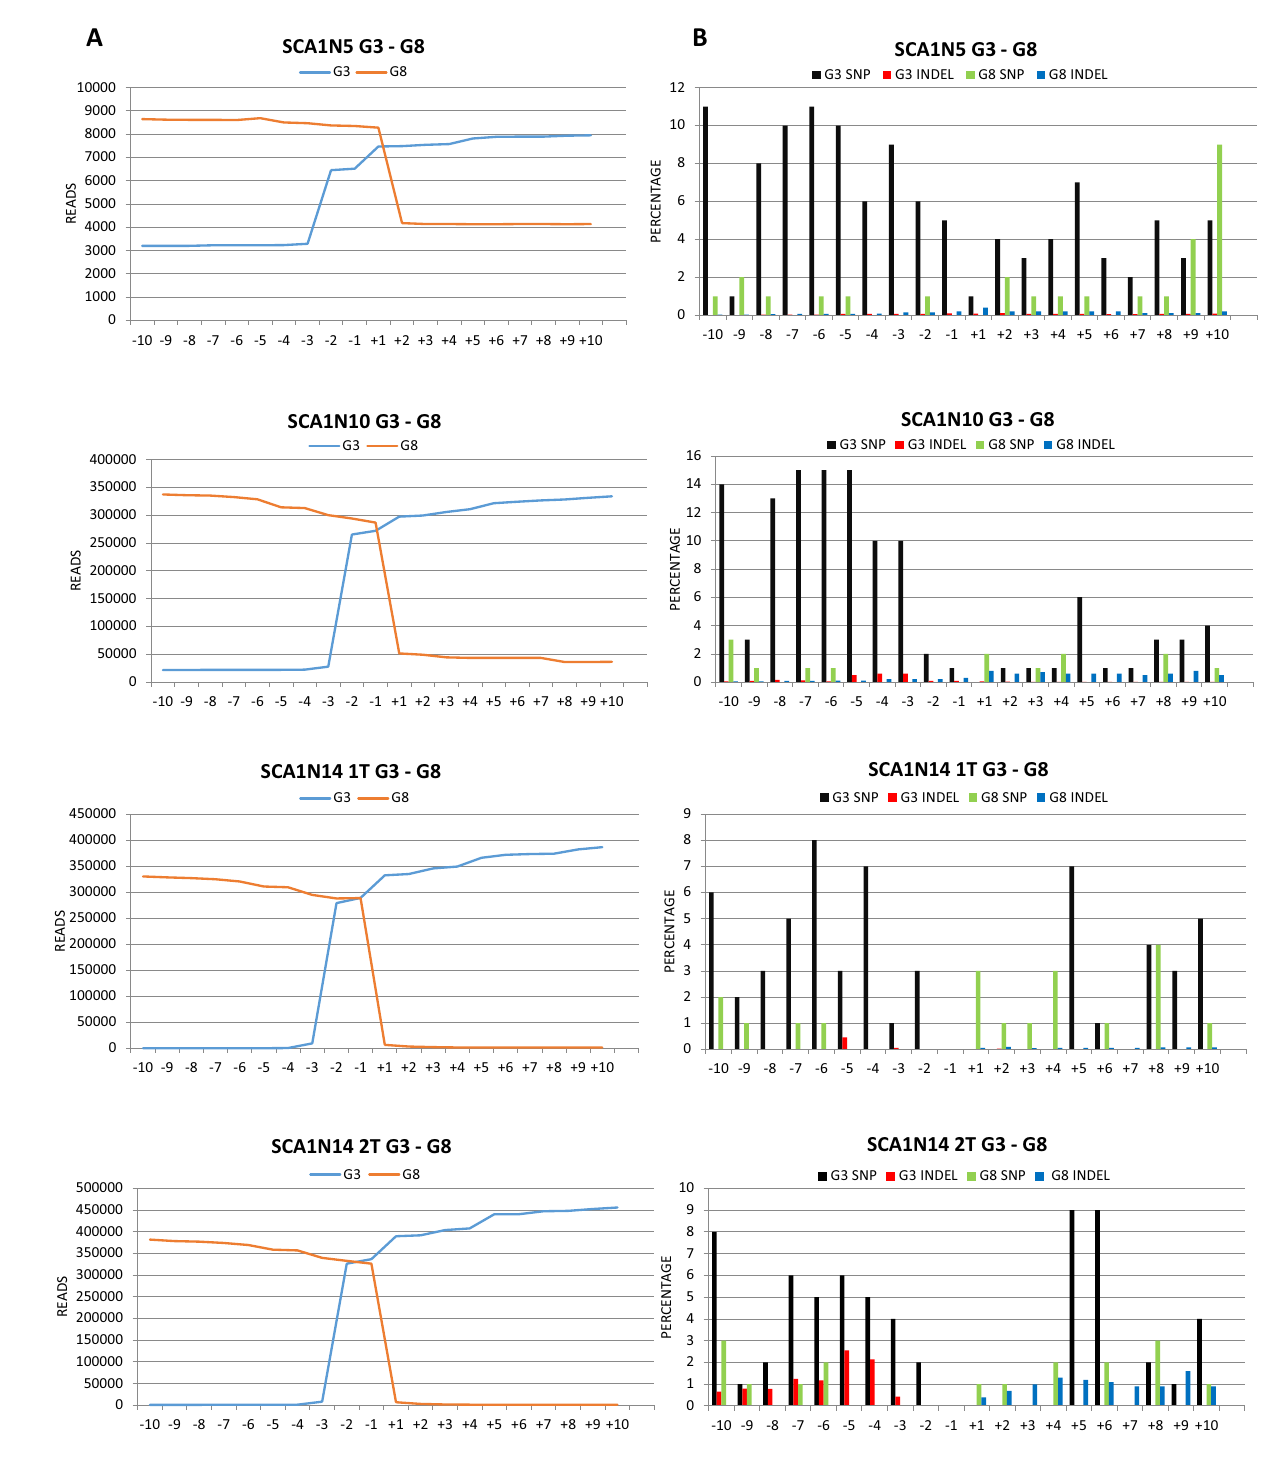
Figure 6. On-target NGS analysis. ( A , B ) represent the total reads count ( A ) and SNPs and indels percentages ( B ) related to the region between 10 nt upstream and 10 nt downstream of the cutting sites in fibroblasts (SCA1N5, SCA1N10, SCA1N14 1 T and SCA1N14 2 T) treated with G3/G8sgRNA-Cas9. ( C , D ) represent the total reads count ( C ) and SNPs and indels percentages ( D ) in fibroblasts (SCA1N14, SCA1N16 and SCA1N19) treated with